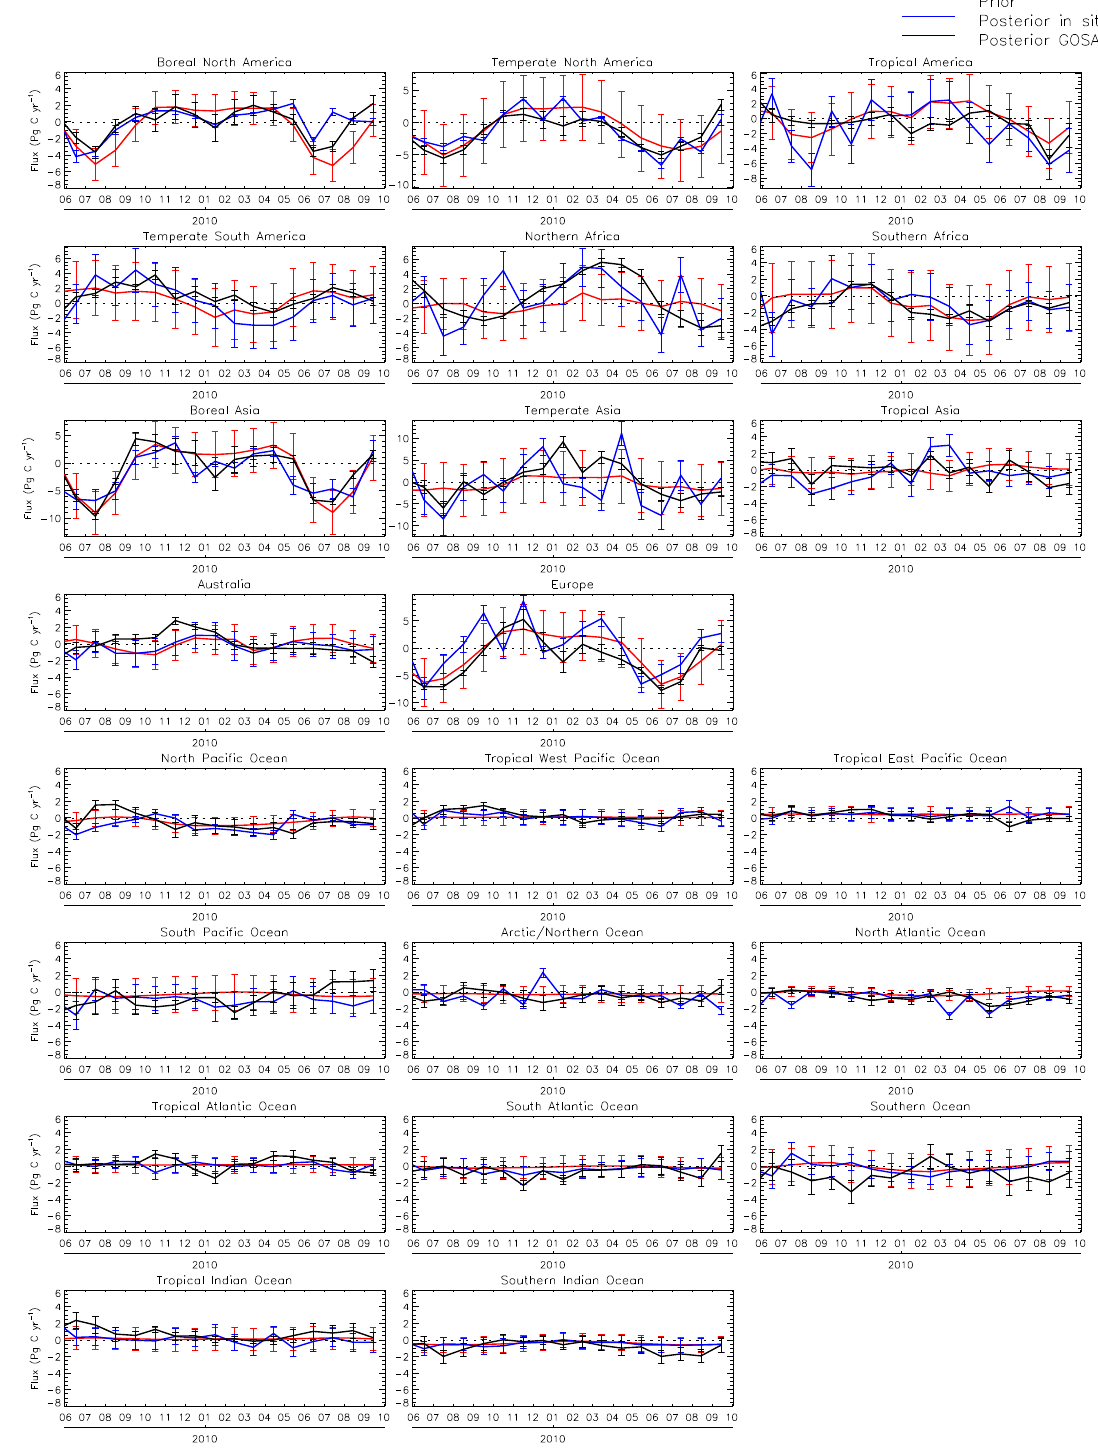
Figure 6. Same as Fig. 5, except showing monthly means of fluxes for all TransCom regions, with error bars that represent 1 σ uncertainties. Component 8-day fluxes and error covariances are weighted by the proportions that lie within each particular